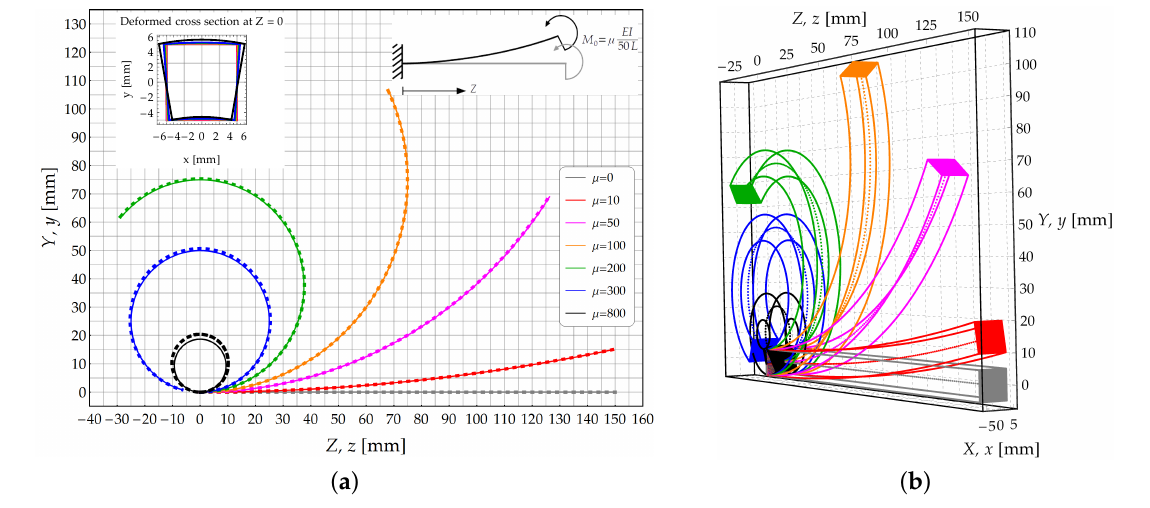
Figure 4. Study case A 1 : Cantilever beam subjected to an external couple acting at its free end. ( a ) Deformed configuration of the longitudinal axis: Theoretical model (continuous lines) and FE model (dashed lines); ( b ) 3D skecth of the deformed configurations obtained by the theoretical